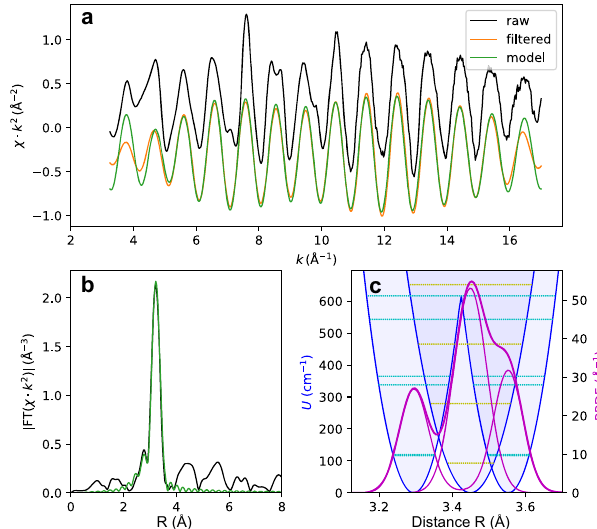
Fig. 7 Strong anharmonicity in YH 3 . The results of the Y K -edge EXAFS spectra treatments for YH 3 at 39 GPa and 10 K. a The raw experimental (black) and fi ltered (red) EXAFS function χ ( k ) k 2 after back Fourier transform (BFT) in the real-space range (2.2 – 3.8 Å ) with the model (green); b The Fourier transform (FT) modulus of EXAFS function χ ( k ) k 2 (black) and the result of fi tting (green) of the fi rst Y(0)-Y(1) shell in the real-space range (2.2 – 3.8 Å ); c The double-well and single-well potentials (blue solid curves) of Y atom vibrations and their PRDF ’ s (dark magenta) for the fi rst Y(0) – Y(1) shell. The resulting PRDF is shown in bold dark magenta curves, the energy levels for the single-well potential are yellow, and the energy levels for the double-well one are dark